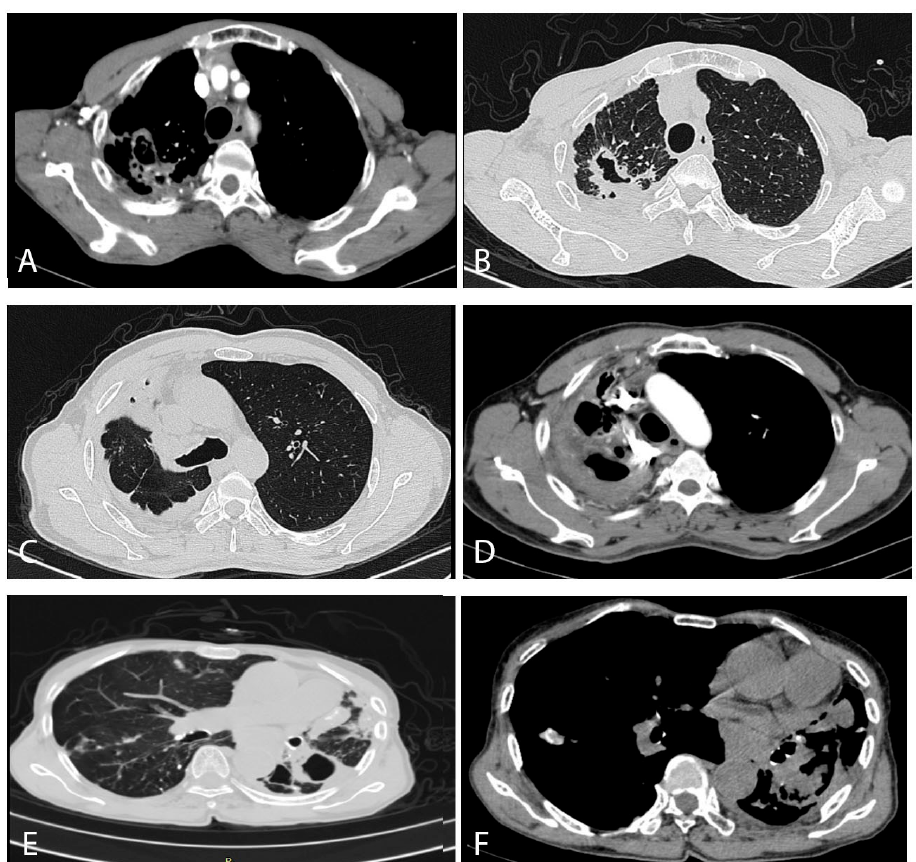
Figure 3. Typical computed tomography findings in our CPA patients. ( A , B ) were from a 71-year-old male patient, ( C , D ) were of a 50-year-old male patient, and ( E , F ) were from a 78-year-old female patient. ( A ) (contrast enhanced scan) shows enlarged arterial vessels on the edge of two separate cavities posteriorly in the right lung. The lung windows from a slightly higher section show a large thick-walled cavity with an irregular interior lining, and probably three other much smaller cavities, in association with remarkable pleural thickening posteriorly, with some pleural fat latero-posteriorly. No aspergilloma is visible in either image. ( C ) shows extensive pleuro-pulmonary fibrosis encasing the right upper lung, with two small cavities (probably) anteriorly. The right main bronchus and mediastinum is shifted to the right. In ( D ), slightly higher in the chest at the level of the aortic arch, shows considerable major arterial blood vessel distortion, additional enlarged arteries within the areas of inflammation or fibrosis and an anterior cavity. ( E ) shows at least one thick-walled cavity at the top of the left overlying an area of significant pleural thickening, with areas of consolidation or fibrosis anteriorly, containing some calcification on a bullous emphysematous background. There is a small area of ill-defined inflammation in the right lung. The bronchial walls contain significant calcification. ( F ) also shows the major mediastinal shift to the left, with extensive areas of consolidation or fibrosis with no particular pattern.